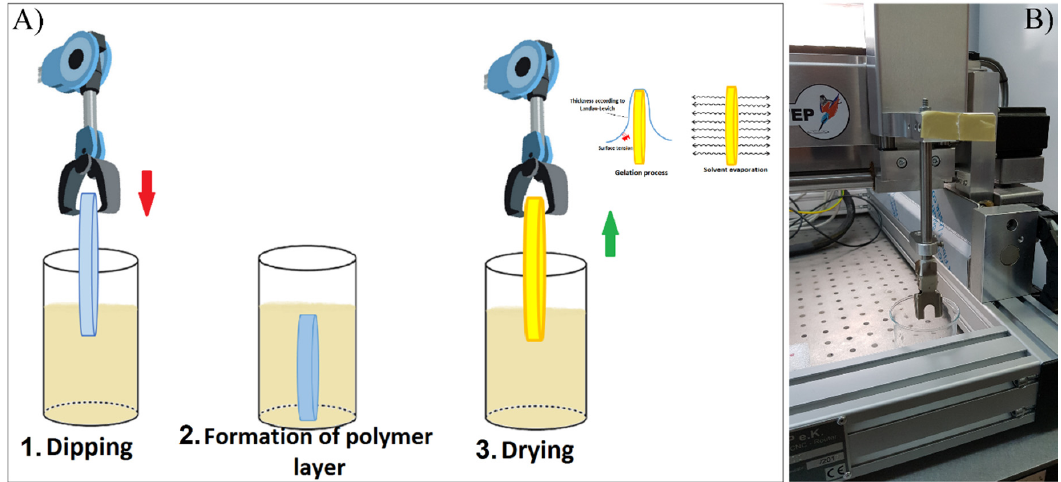
Figure 1. Dip-coating (DC) experimental set-up: ( A ) schematic description of the polymer deposition process: 1. dipping; 2. formation of the polymer layer; 3. drying. In this stage, the solvent evaporation occurs simultaneously with the gelation process, the thickness of the yielded coating being estimated according to the Landau–Levich theory. ( B ) Photograph of the laboratory set-up.